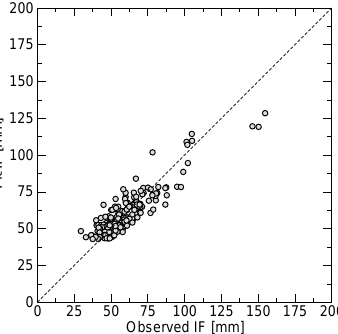
Figure 4. Estimated vs. observed IFs at the station